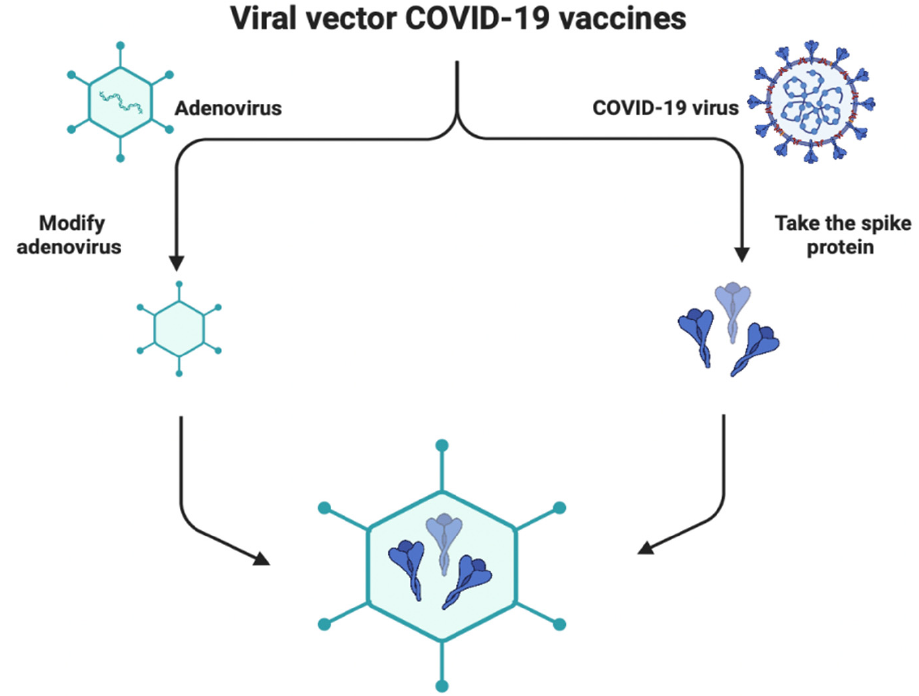
Figure 5. Development of COVID-19 viral vector vaccine.